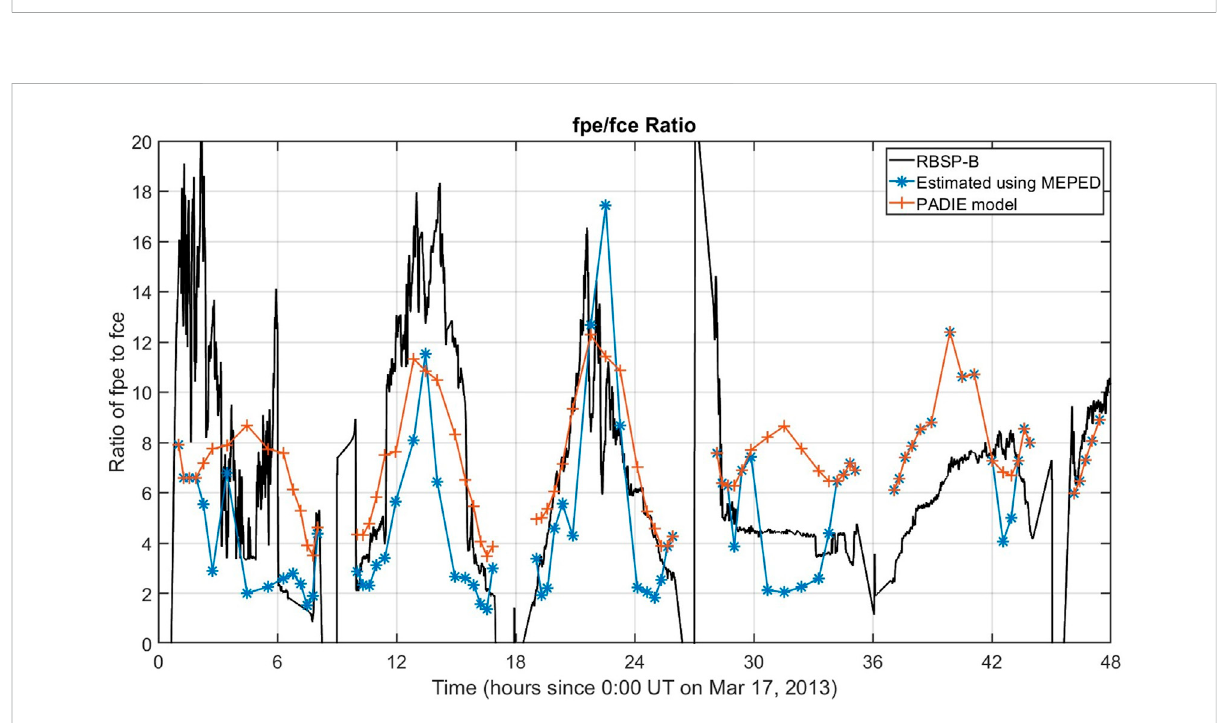
FIGURE 9 Same as Figure 8, except showing the plasma-gyrofrequency ratio f pe / f ce